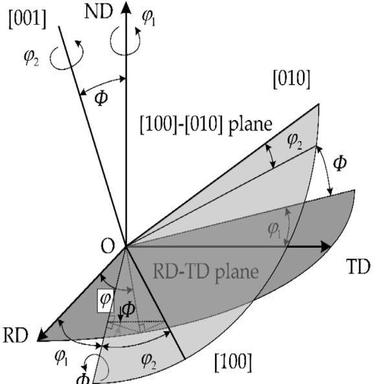
Definition of Bunge Euler angles and projected angle φ.